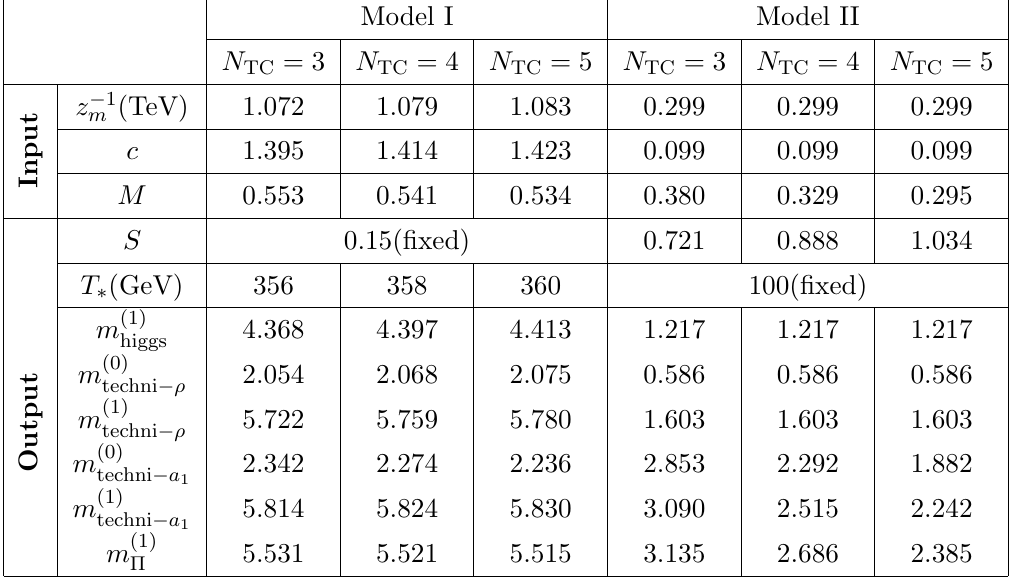
Table 1 . Model I (cid:12)ts three experimental data S = 0 : 15, m (0) = 125GeV and f (cid:5) = 246GeV. higgs Model II (cid:12)ts two experimental data m (0) = 125GeV, f (cid:5) = 246GeV and assumes a phase transition higgs temperature of 100 GeV. Note that the unit of particle mass is